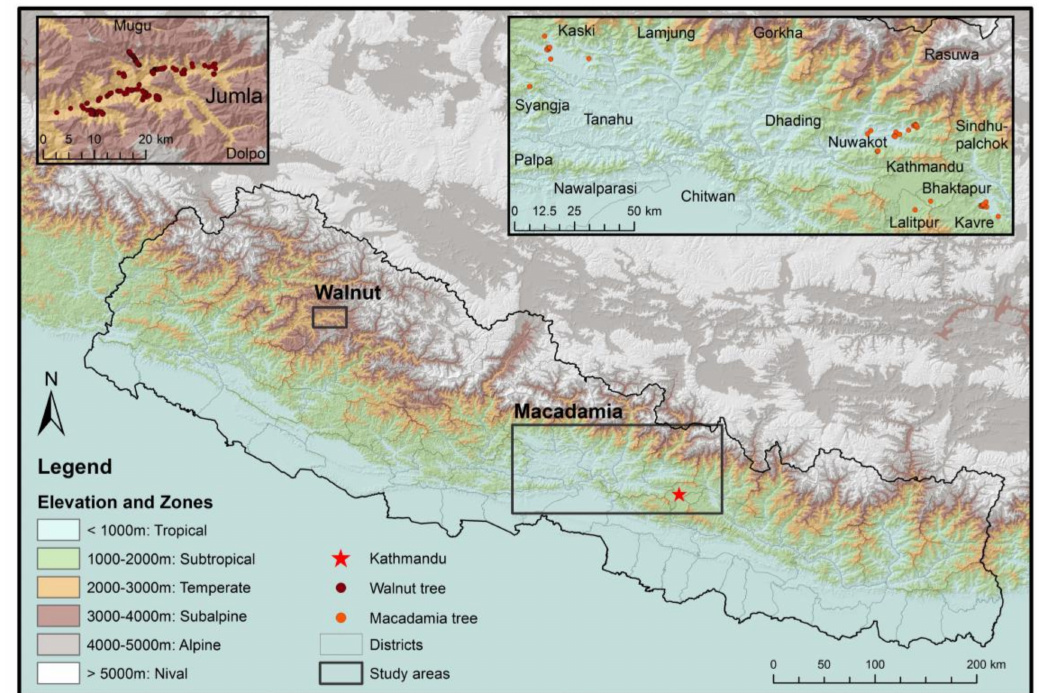
Figure 1. Overview of study areas in